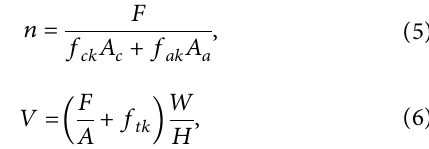
Table 1: Experimental objectives of the study. Serial number